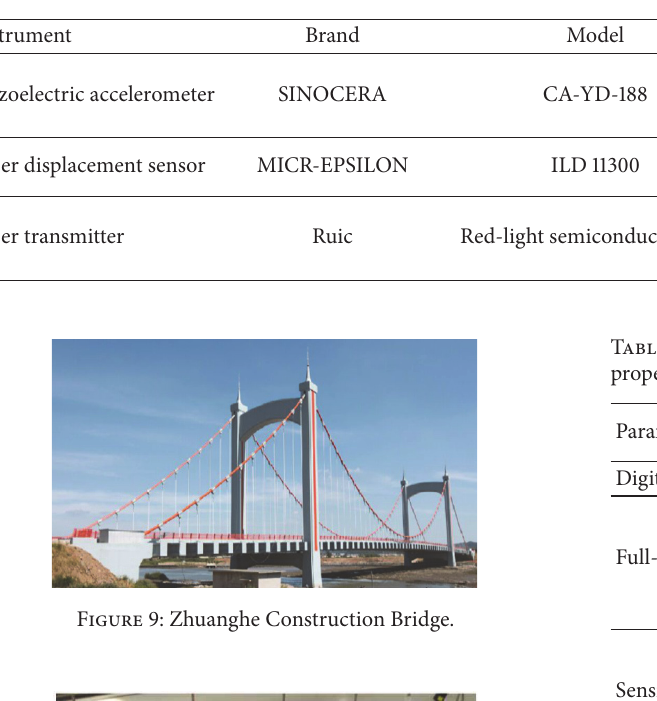
Table 3: Main instruments parameters.